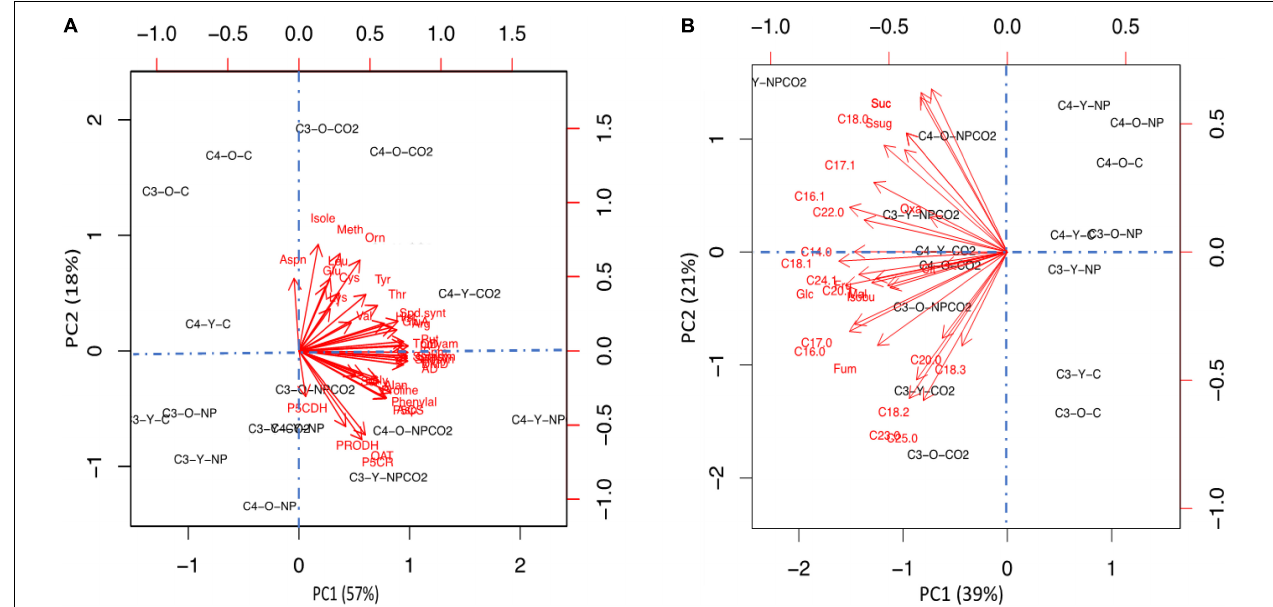
FIGURE 6 | Principal component analysis (PCA) to investigate the variability of data for both carbon metabolites (A) and nitrogen metabolites (B) . The arrows showed which variables are most correlated with the principal components (PCs). The link between variables is defined by the arrow